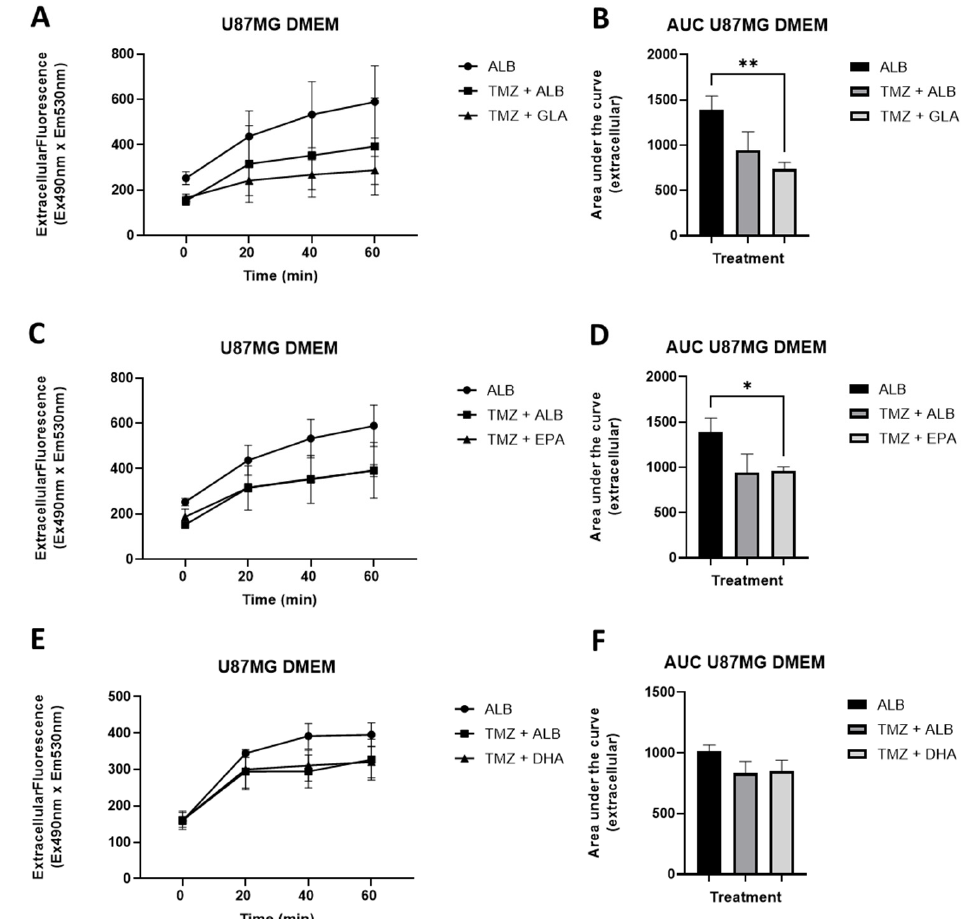
Figure 11. Effects of gamma-linolenic acid (GLA), eicosapentaenoic acid (EPA), and docosahexaenoic acid (DHA) on rhodamine 123 efflux in U87MG cells: ( A ) Efflux ± GLA. ( B ) Area under curve for efflux ± GLA. ( C ) Efflux ± EPA ( D ) Area under curve for efflux ± EPA. ( E ) Efflux ± DHA. ( F ) Area under curve for efflux ± DHA. Data are presented as mean ± SEM, N = 3. Differences were considered significant at p < 0.05. * = p < 0.05; ** = p < 0.01. In U87MG cells, 100 µ M EPA + TMZ caused a significant decrease in extracellular concentration of R123 in comparison with the albumin control. However, the presence of EPA did not alter the extracellular concentration of R123 in comparison with albumin + TMZ for U87MG cells (Figure 11C,D). The presence of DHA had no effect on U87MG extracellular R123 concentration (Figure 11E,F). In contrast with the data for U87MG cells, the TMZR cells showed no significant changes in extracellular R123 in the presence of 100 µ M GLA, EPA, or DHA of the PUFAs studied (Figure